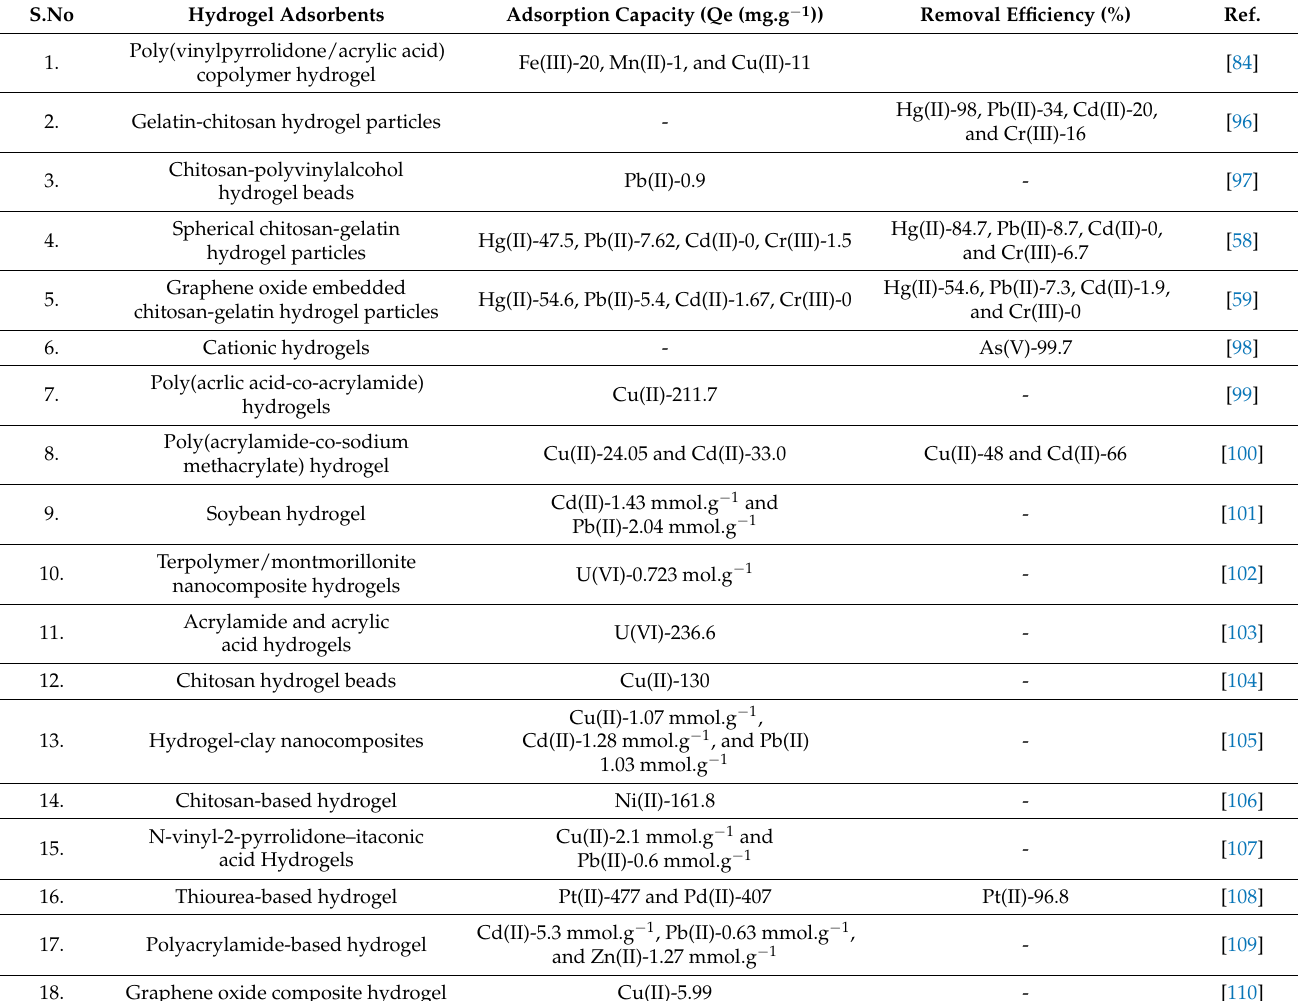
Table 1. Adsorption capacity and removal efficiency of heavy metal ions using different adsorbents in single metal ion